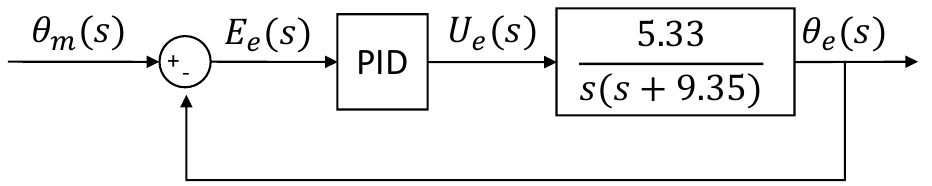
Figure 15. Slave control loop block diagram.